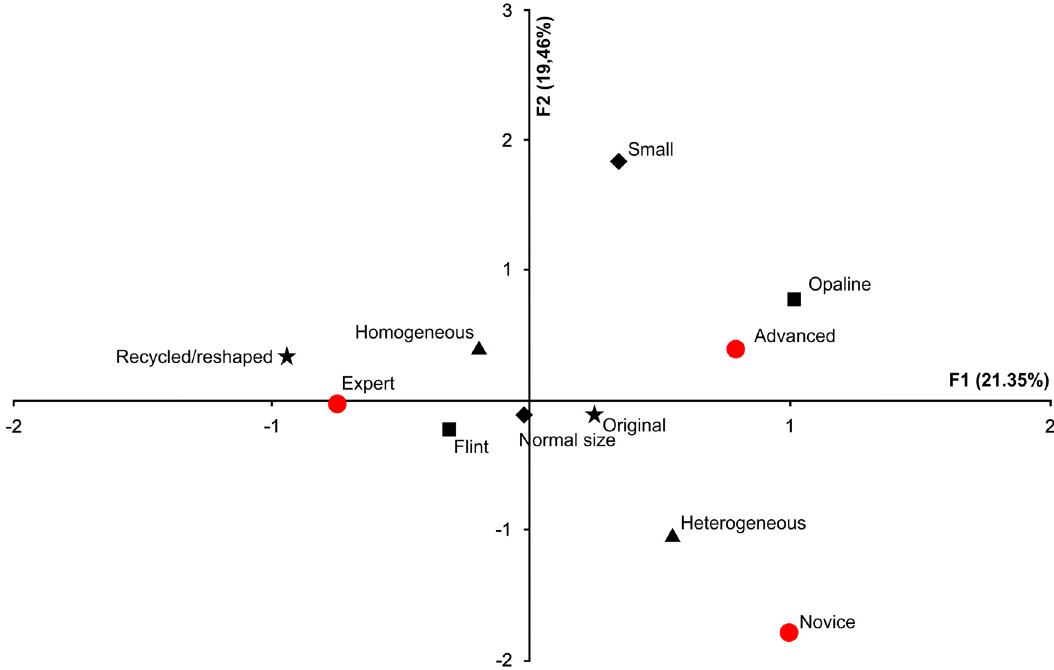
Figure 6: Multiple correspondence analyses between raw material selection and skill: factors 1 and